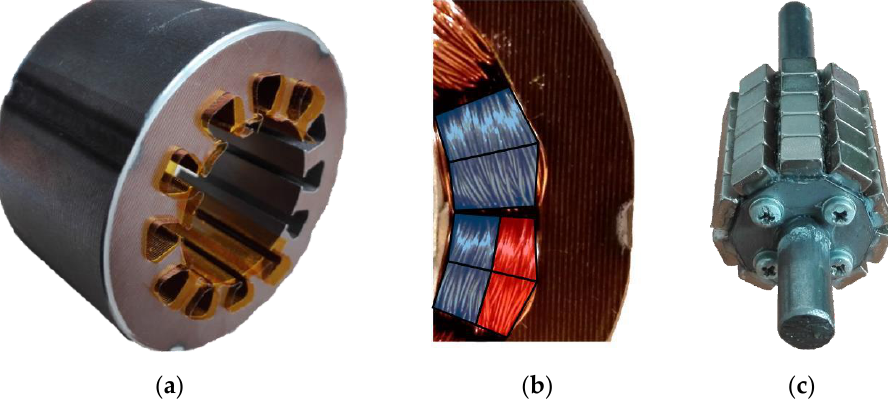
Figure 8. Parts of the machine: stator with partially inserted slot insulation layer ( a ), detailed look at the wound stator with highlighted coils belonging to different phases ( b ), and rotor with mounted permanent magnets ( c ).